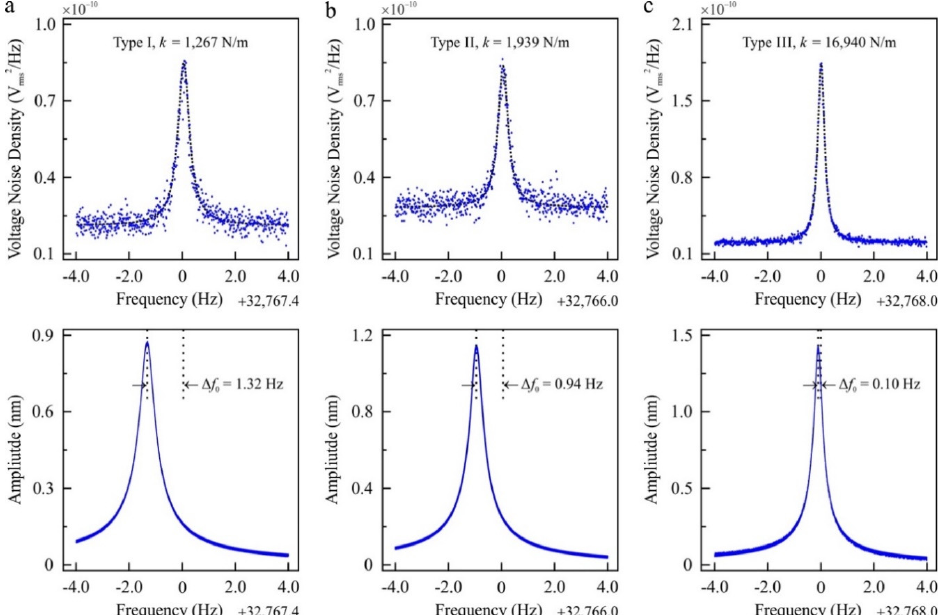
Figure 1. The measurement of the resonance frequency of encapsulated tuning forks with thermal noise density (first row, a – c ) and frequency sweep experiments (second row, a – c ). A Lorentzian curve is fitted to the thermal noise density and the resonance frequency is calculated from the fit.